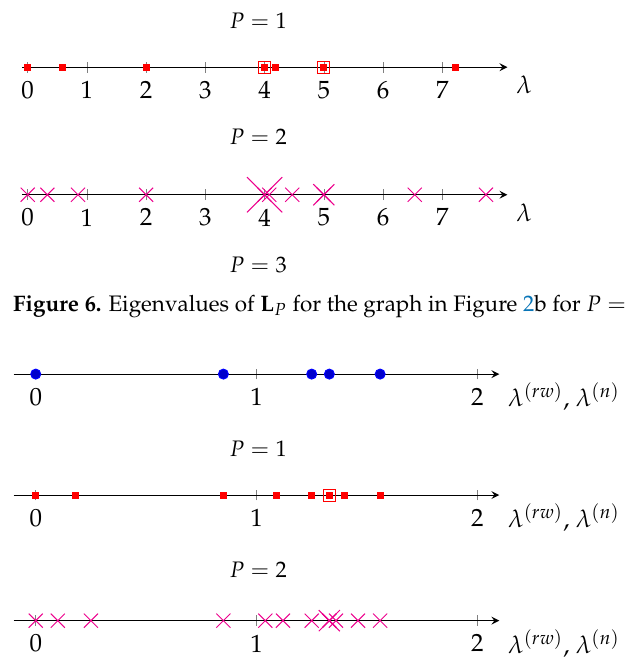
( rw ) ( n ) and L for the graph in Figure 2b for P = { 1,2,3 } P P